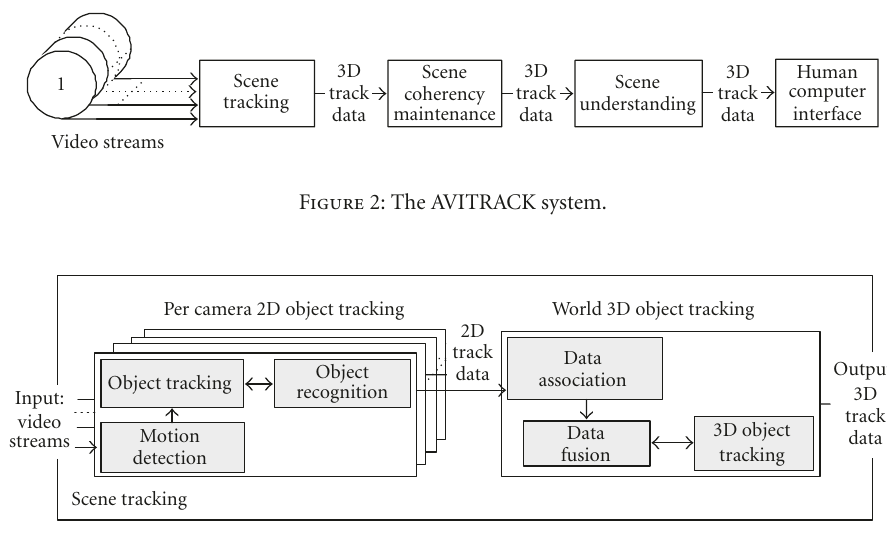
Figure 3: The scene tracking module in the AVITRACK